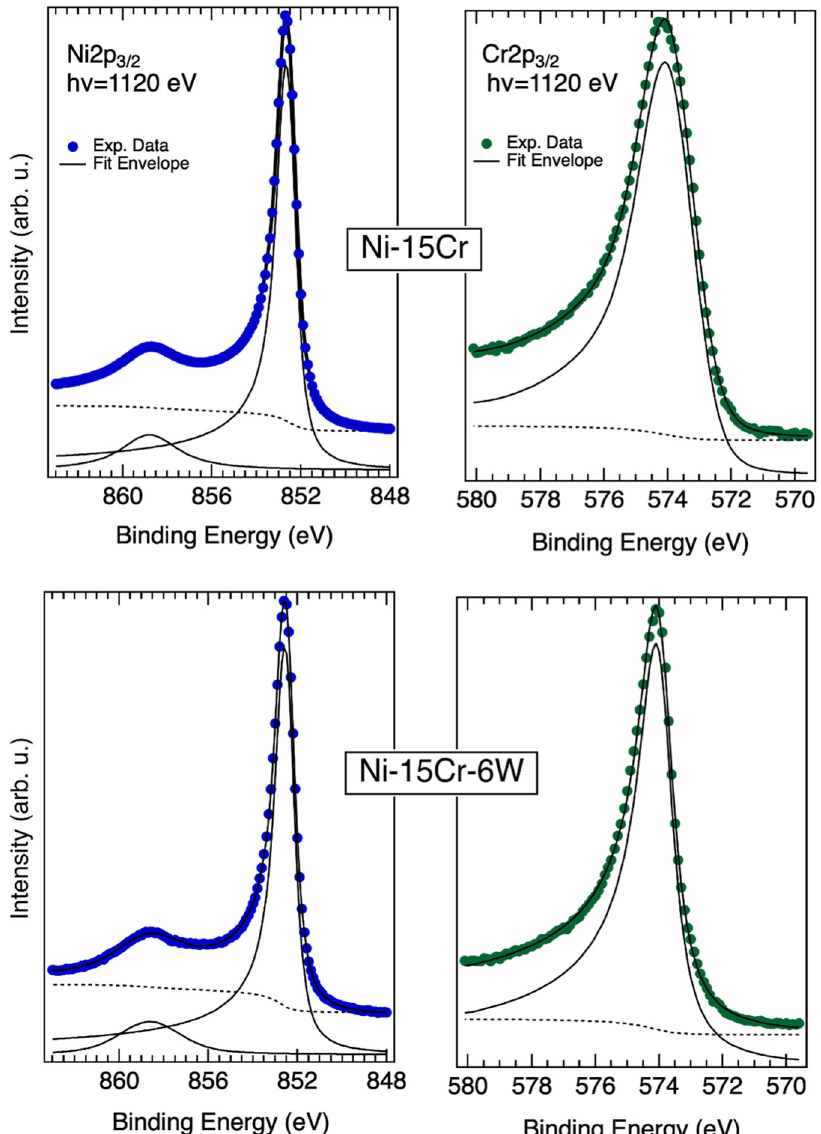
Fig. 1 Alloy core level spectra. Ni 2p 3/2 and Cr 2p 3/2 core level spectra including experimental data (symbols) and fi t results for a binary and ternary alloy with the same Ni/Cr ratio. The fi t envelope and fi t peaks with a Doniach-Sunic lineshape are marked as a full line, the Shirley background is the broken line. The Ni 2p 3/2 peak includes the satellite